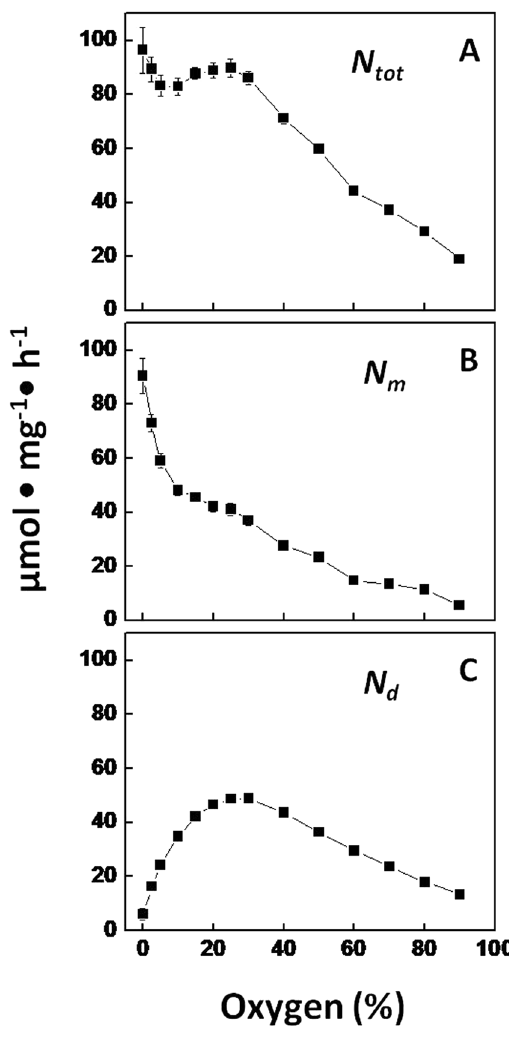
Figure 1. Nitrogenase activity (chlorophyll-specific rate of acetylene reduction) at different external O 2 concentrations and a fixed temperature of 30 °C. ( A ) N tot , the total nitrogenase activity at light saturation; equals N m + N d . ( B ) N m , the maximum light-dependent nitrogenase activity at light saturation. ( C ) N d , the light- independent (dark) nitrogenase